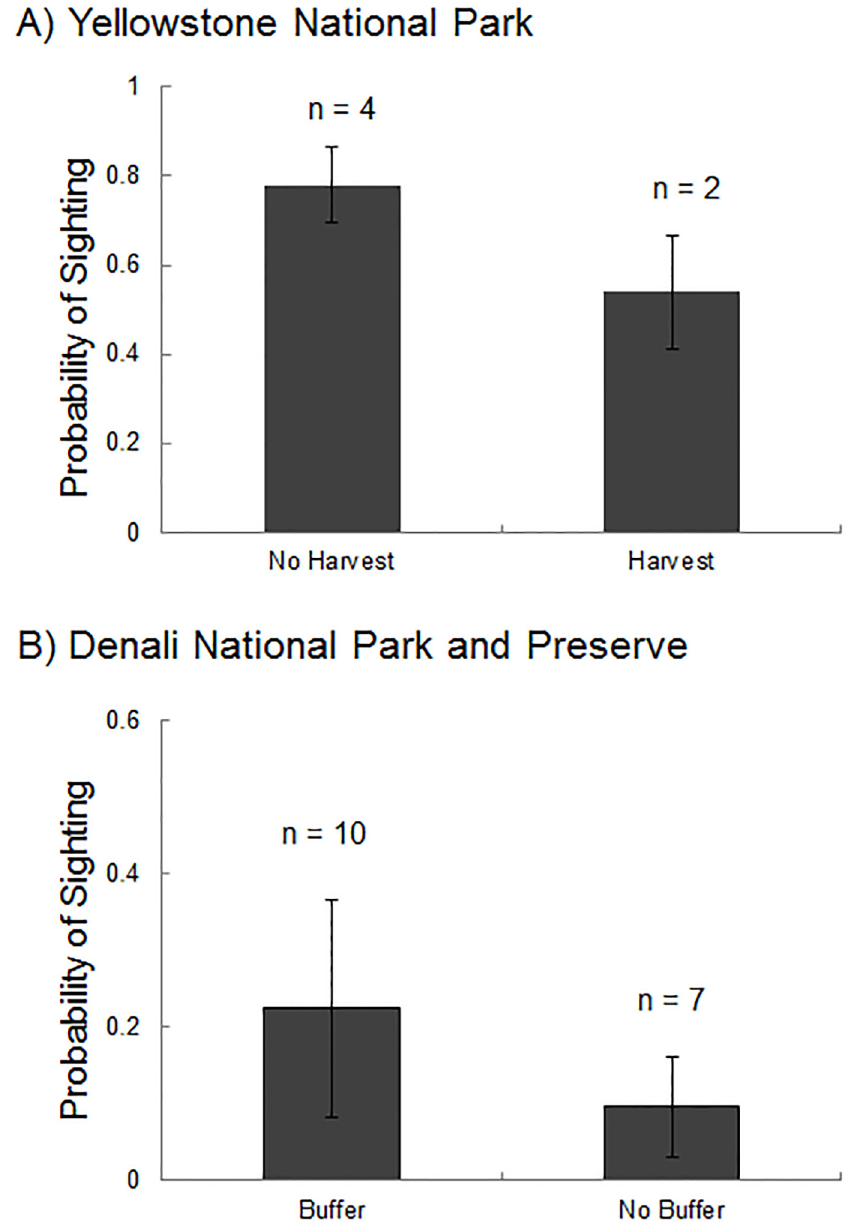
Fig 3. Mean probability of sighting for wolves A) in Lamar Valley and Little America following years with and without harvest of pack wolves, Yellowstone National Park, Wyoming, USA and B) along the Denali Park Road following years with and without the presence of a buffer zone prohibiting the trapping and hunting of wolves outside of Denali National Park and Preserve, Alaska, USA. Standard error bars and sample sizes (number of years) are